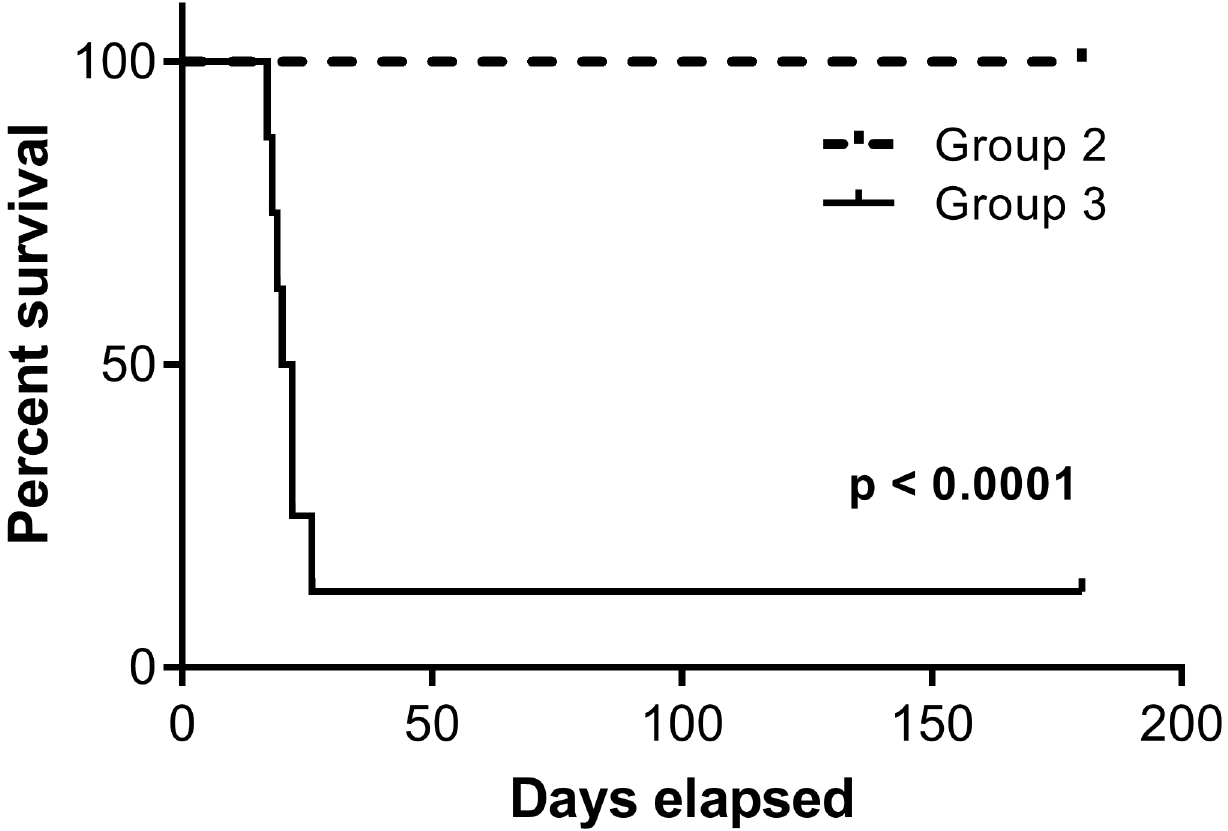
Fig 3. The survival curves of vaccinees and controls after rabies challenge. 198 day post-vaccination, vaccinees receivingSAG2 in 10 8 per dose (Group 2) and controls in Group 3 were challenged with Taiwan ferret badgerrabiesvirus in 10 3.2 MICLD 50 . After 180-day observation, the statistic analysisshoweda statistically significantdifference on survival curves between Groups 2 and